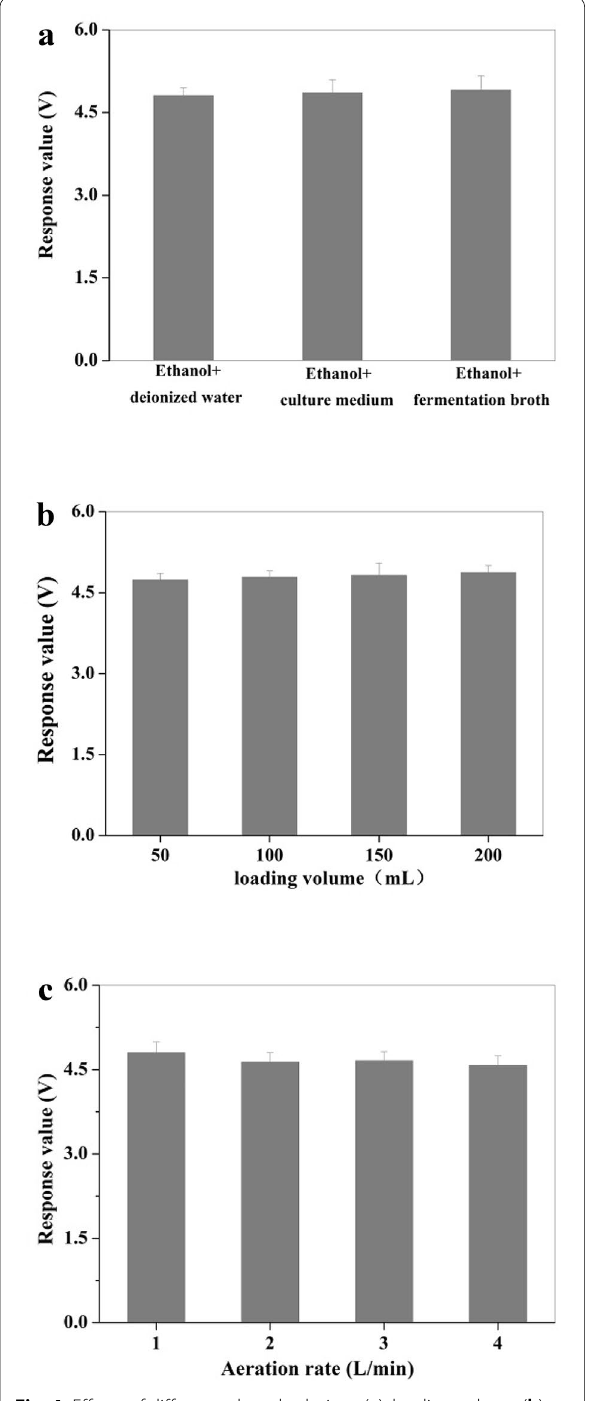
Fig. 4 Effects of different ethanol solutions ( a ), loading volume ( b ), and aeration ( c ) on the determination of ethanol concentration in electronic nose-3 channel